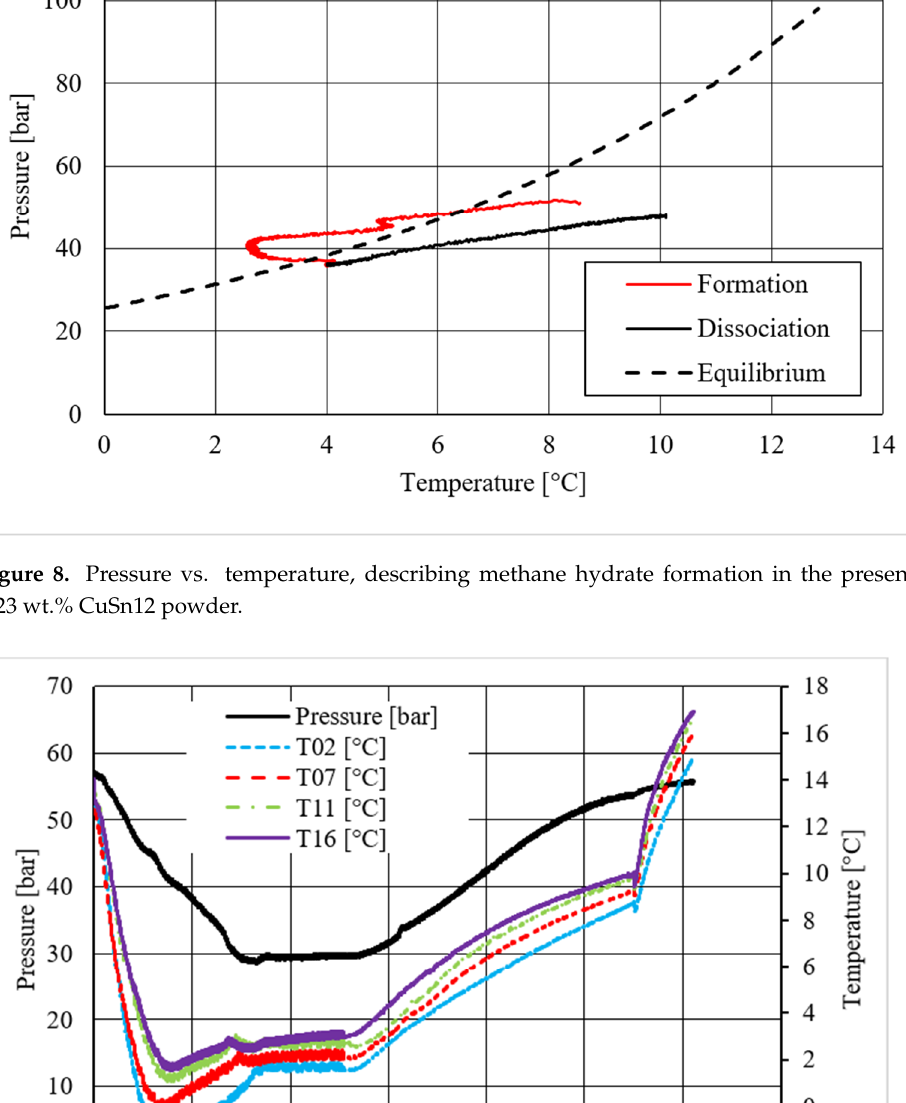
Figure 7. Pressure and temperature trends over time, measured for methane hydrate formation in the presence of 4.23 wt.% CuSn12 powder.